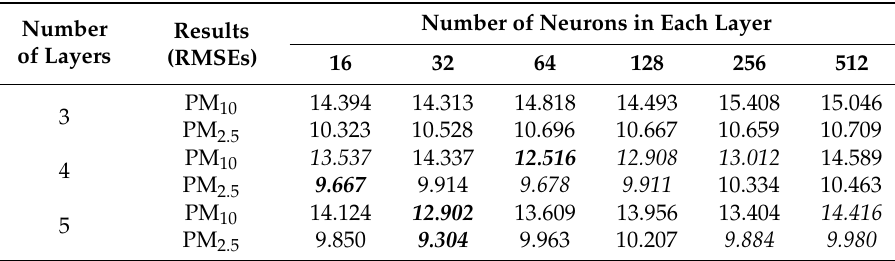
Table 5. The e ff ects of neuron numbers.